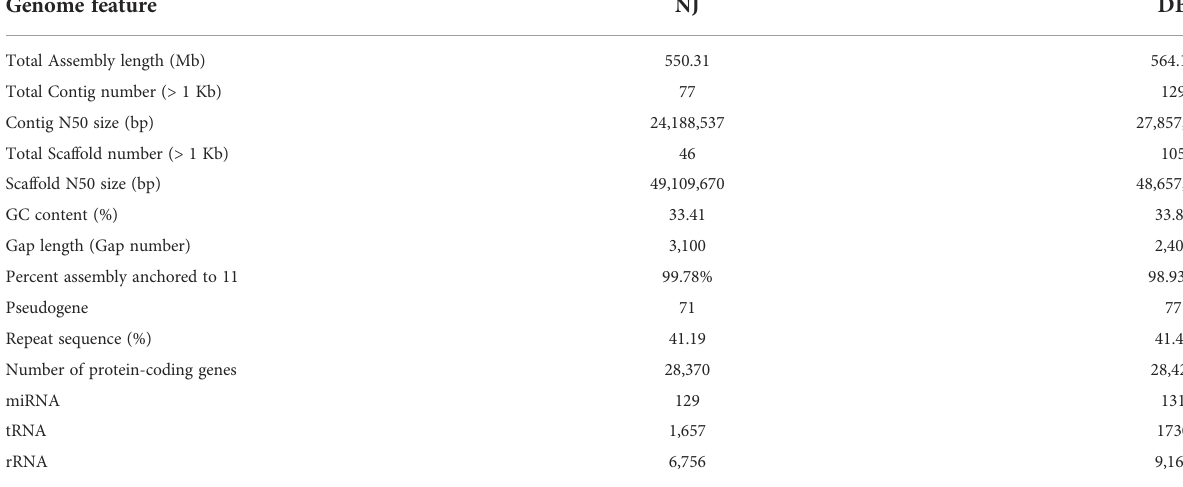
TABLE 1 Assembly features of the NJ and DB genomes. Genome